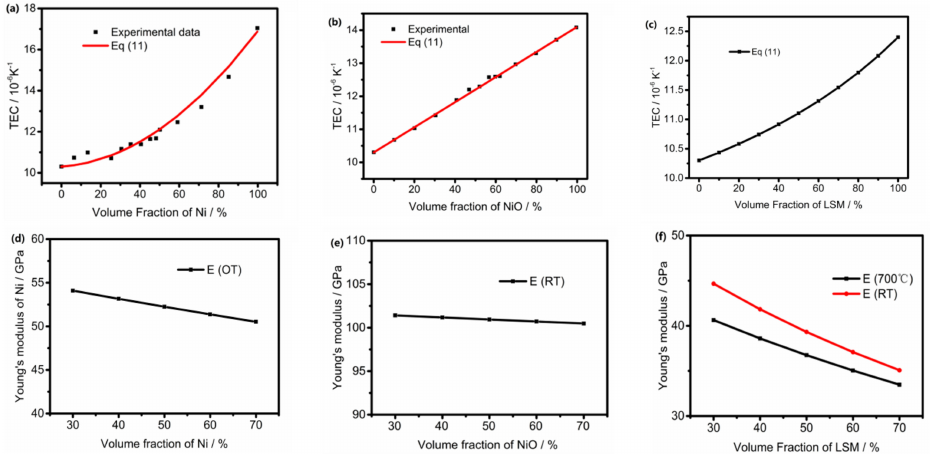
Figure 2. Effective mechanical properties of porous electrode: ( a ) Comparison of theoretical and experimental thermal expansion coefficient (TEC) of Ni-YSZ anode; ( b ) Comparison of theoretical and experimental TEC of NiO-YSZ anode; ( c ) TEC of LSM-YSZ cathode; ( d ) Young’s modulus of Ni-YSZ anode at OT; ( e ) Young’s modulus of NiO-YSZ anode at RT; ( f ) Young’s modulus of LSM-YSZ cathode at OT and